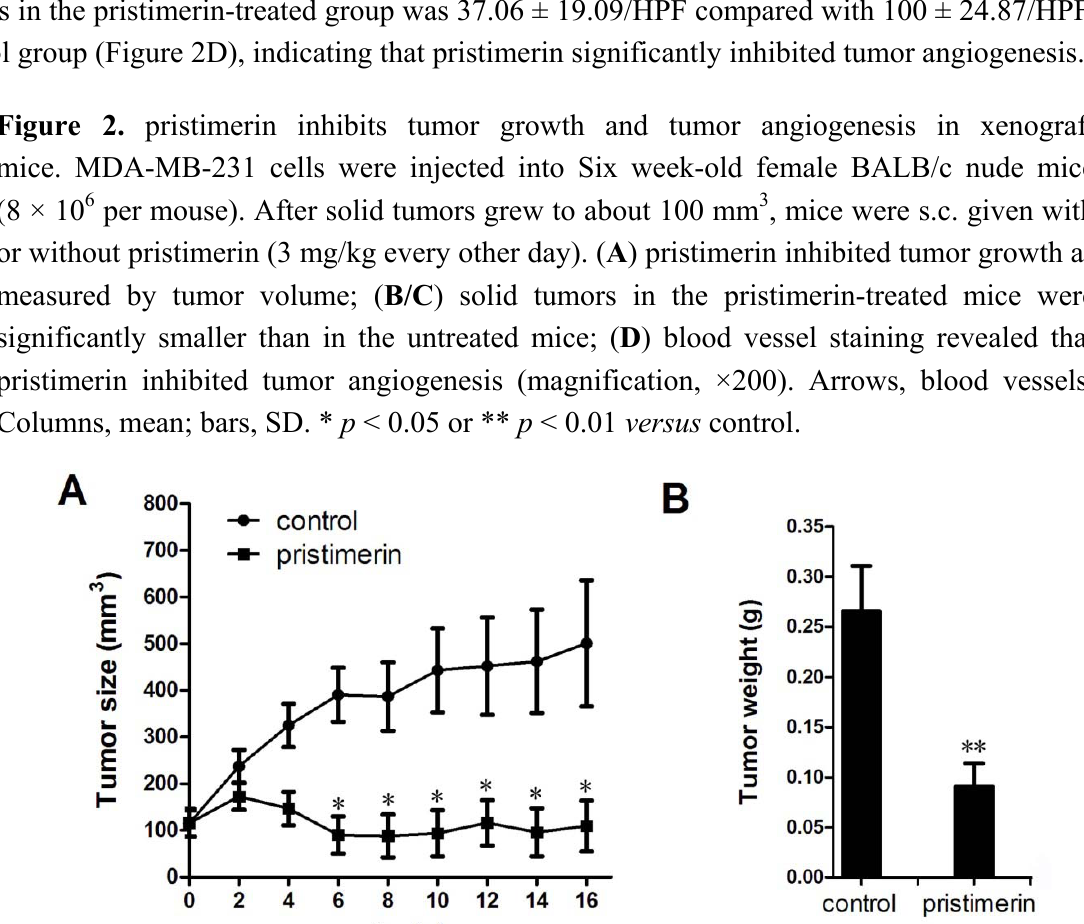
Figure 2. pristimerin inhibits tumor growth and tumor angiogenesis in xenograft